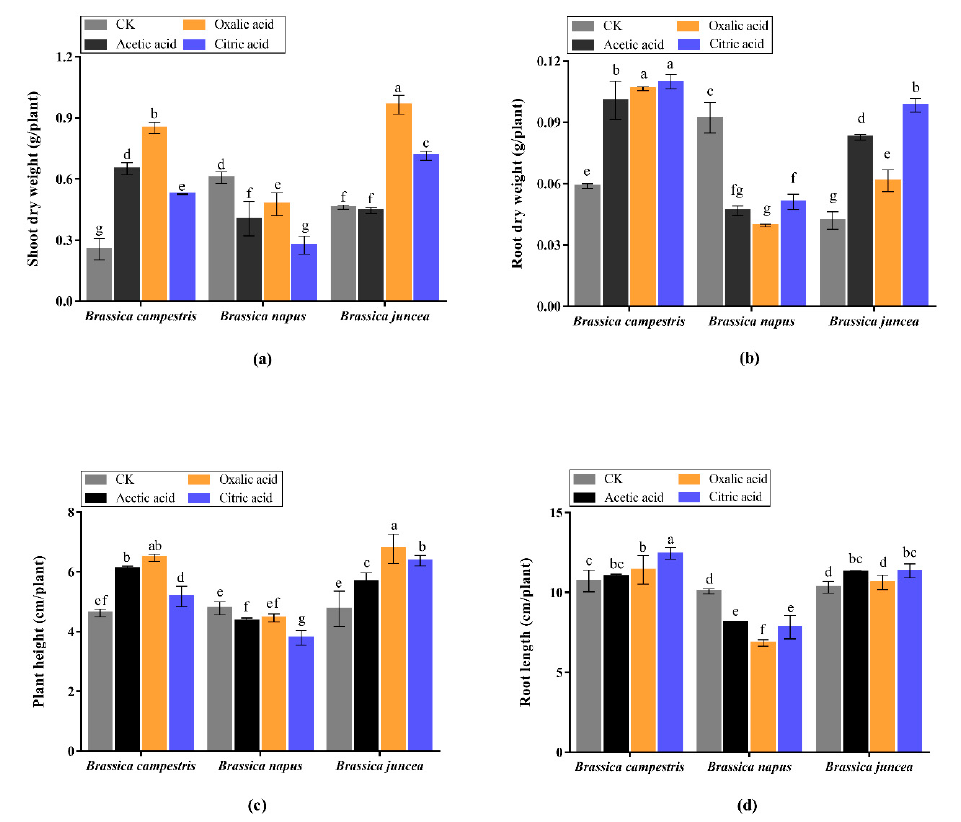
Figure 2. Seedling growth for the three Brassica species in presence of 20 mg/kg Cd and following organic acid treatment. The Values are means ± SE from three biological replicates. Values followed by different letters indicate statistical significance based on two-way ANOVA ( p < 0.05). ( a ) Shoot dry weight. ( b ) Root dry weight. ( c ) Plant height. ( d ) Root length.